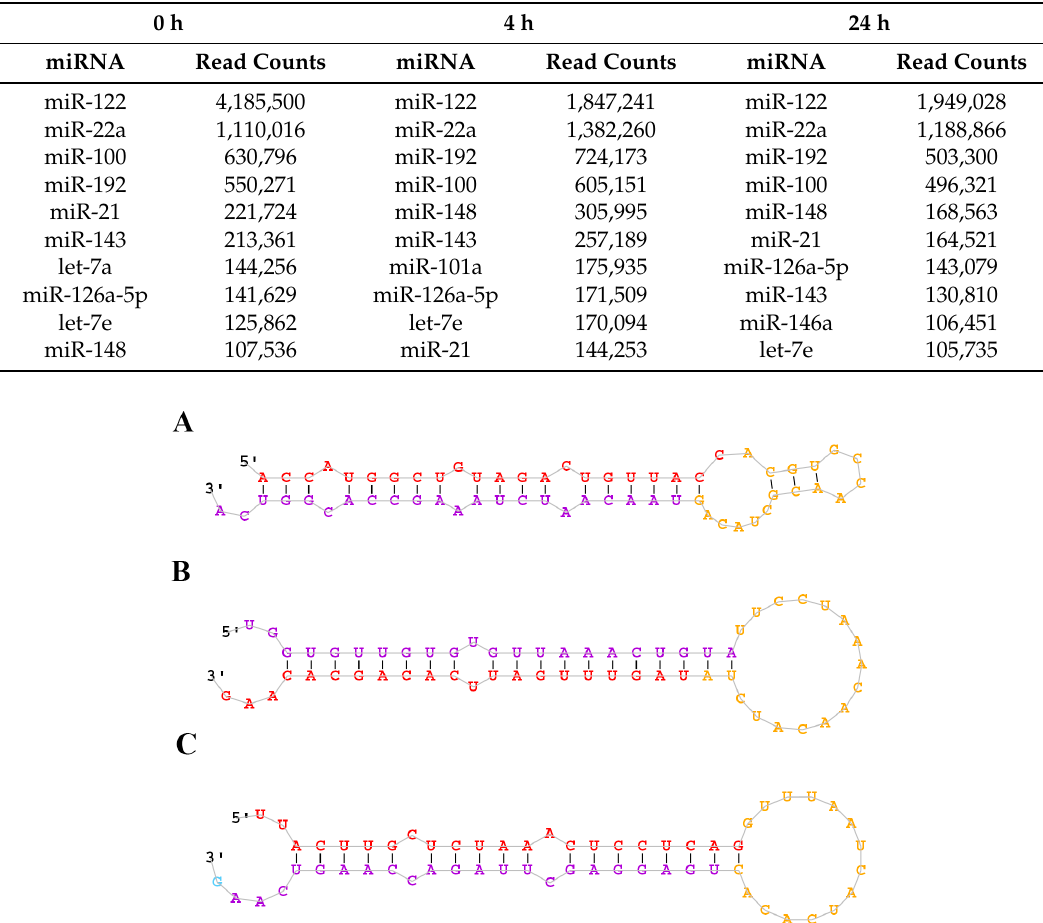
Table 1. The top 10 most abundant miRNAs in the small RNA libraries generated from the liver of M. amblycephala at various time points post-infection with A. hydrophila .